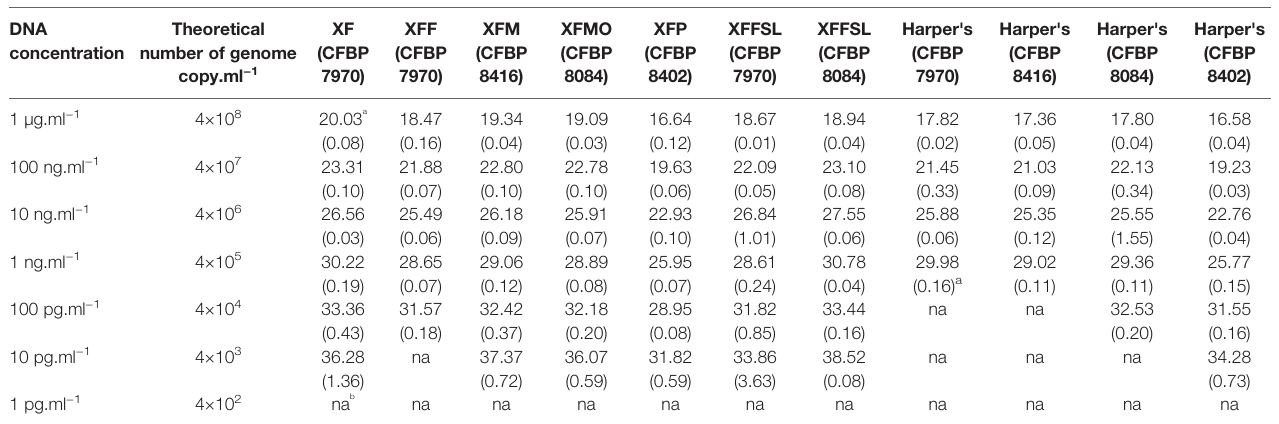
TABLE 4 | Ef fi ciency of the primer and probe sets in simplex qPCR assays on extracted DNA of bacterial strains in comparison with the Harper's test (Harper et al., 2010). A, Mean Ct value for each primer and probe set on target strains. B, Percentage of ef fi ciency and standard curve parameters of each primer and probe set on target